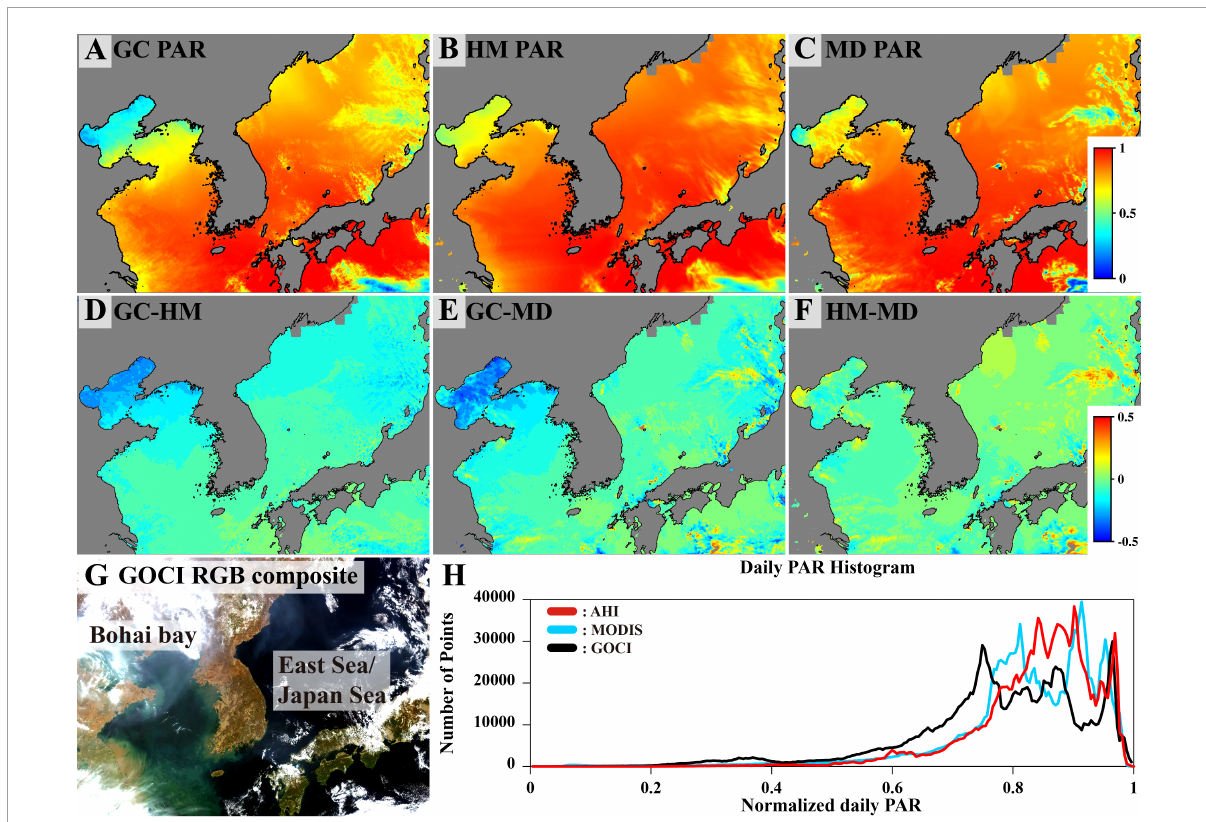
FIGURE 8 Comparison of daily PAR images captured on March 17, 2017 among three sensors. (A–C) Normalized daily PAR from GOCI (GC), AHI (HM), and MODIS (MD). (D–E) Difference map among the three sensors. (G) RGB composite image of GOCI data captured at UTC 03 March 17, 2017. (H) Histogram of daily PAR image data from the three sensors on March 17,